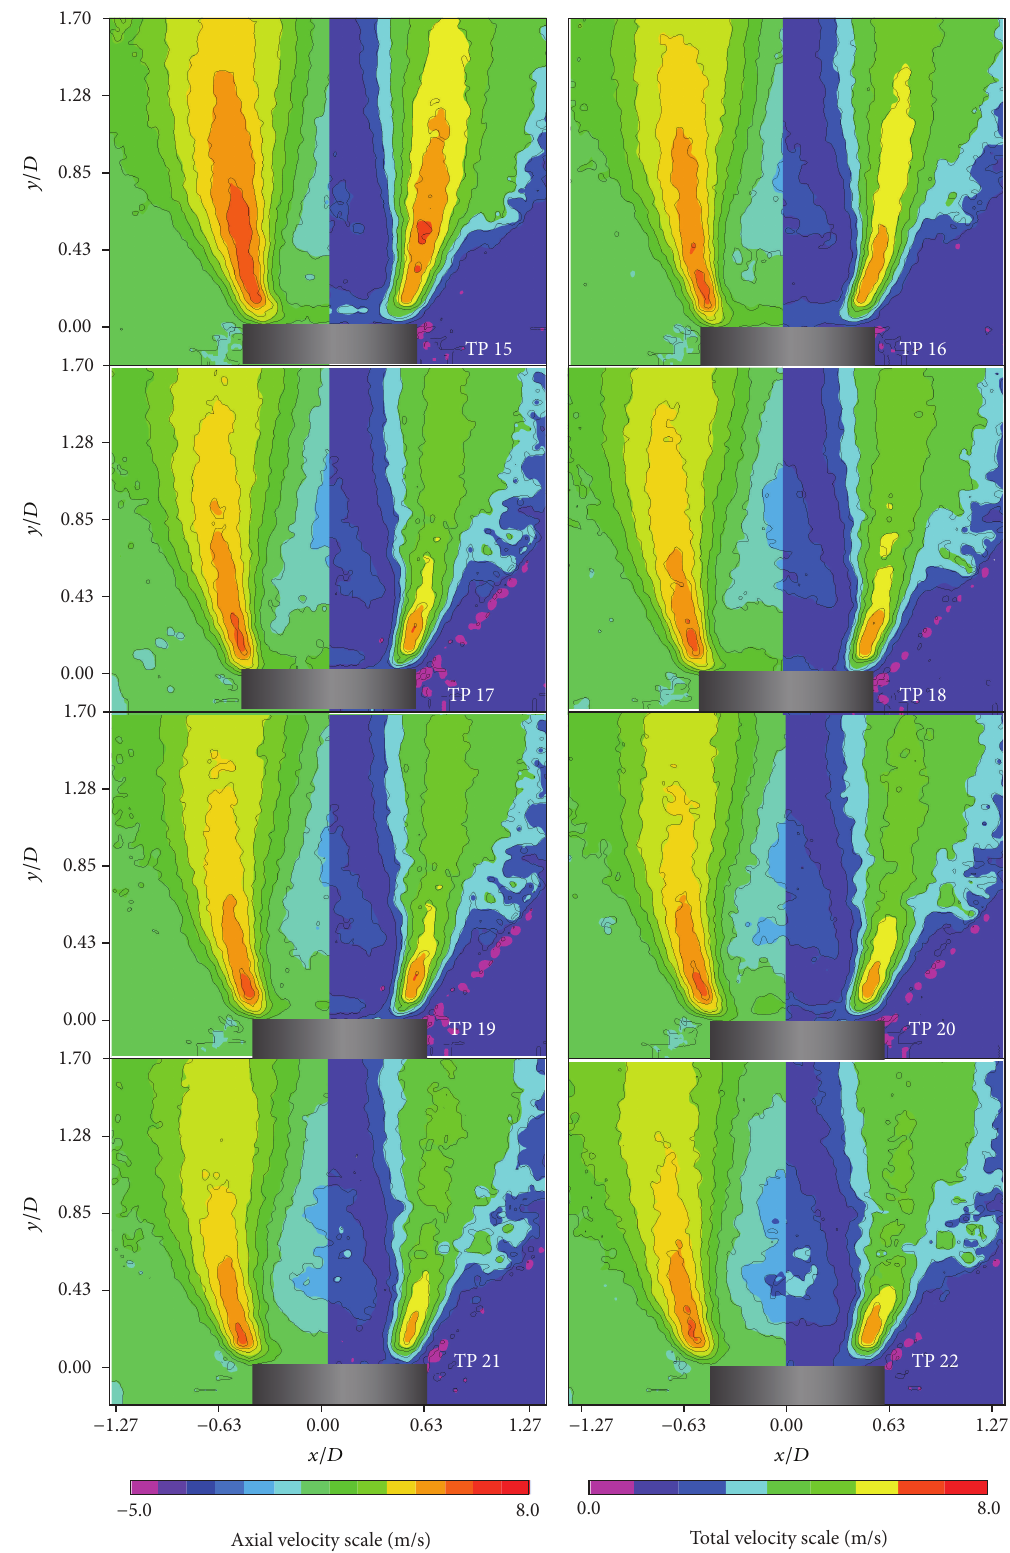
Figure 5: Scalar plots of TP 15 to TP 22 in the AGSB as detailed in Table 1, the left half of each image indicates axial velocity, and the right half total